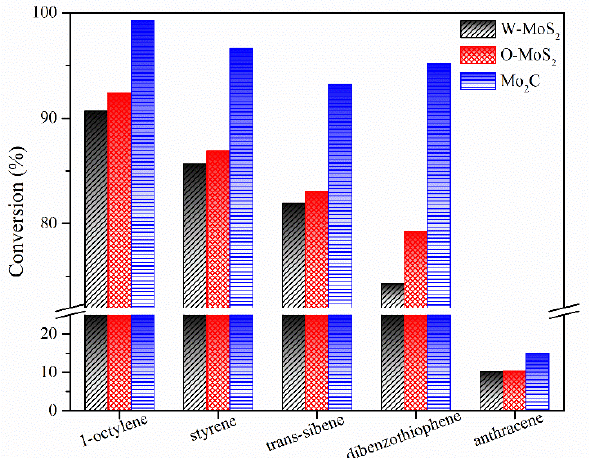
Figure 6. Conversion of model compounds on various catalysts.